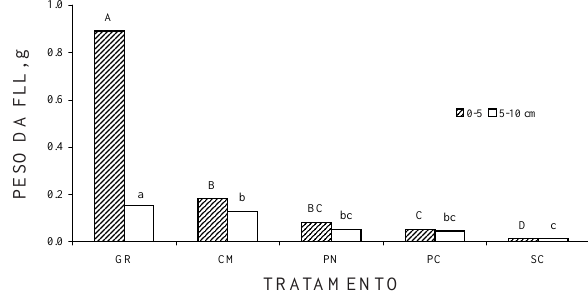
Figura 2. Distribuição do peso da fração leve livre nos diferentes tratamentos. Médias seguidas da mesma letra maiúscula, para 0-5 cm, e da mesma letra minúscula para 5–10 cm, não diferem entre si (Tukey p< 0,05).